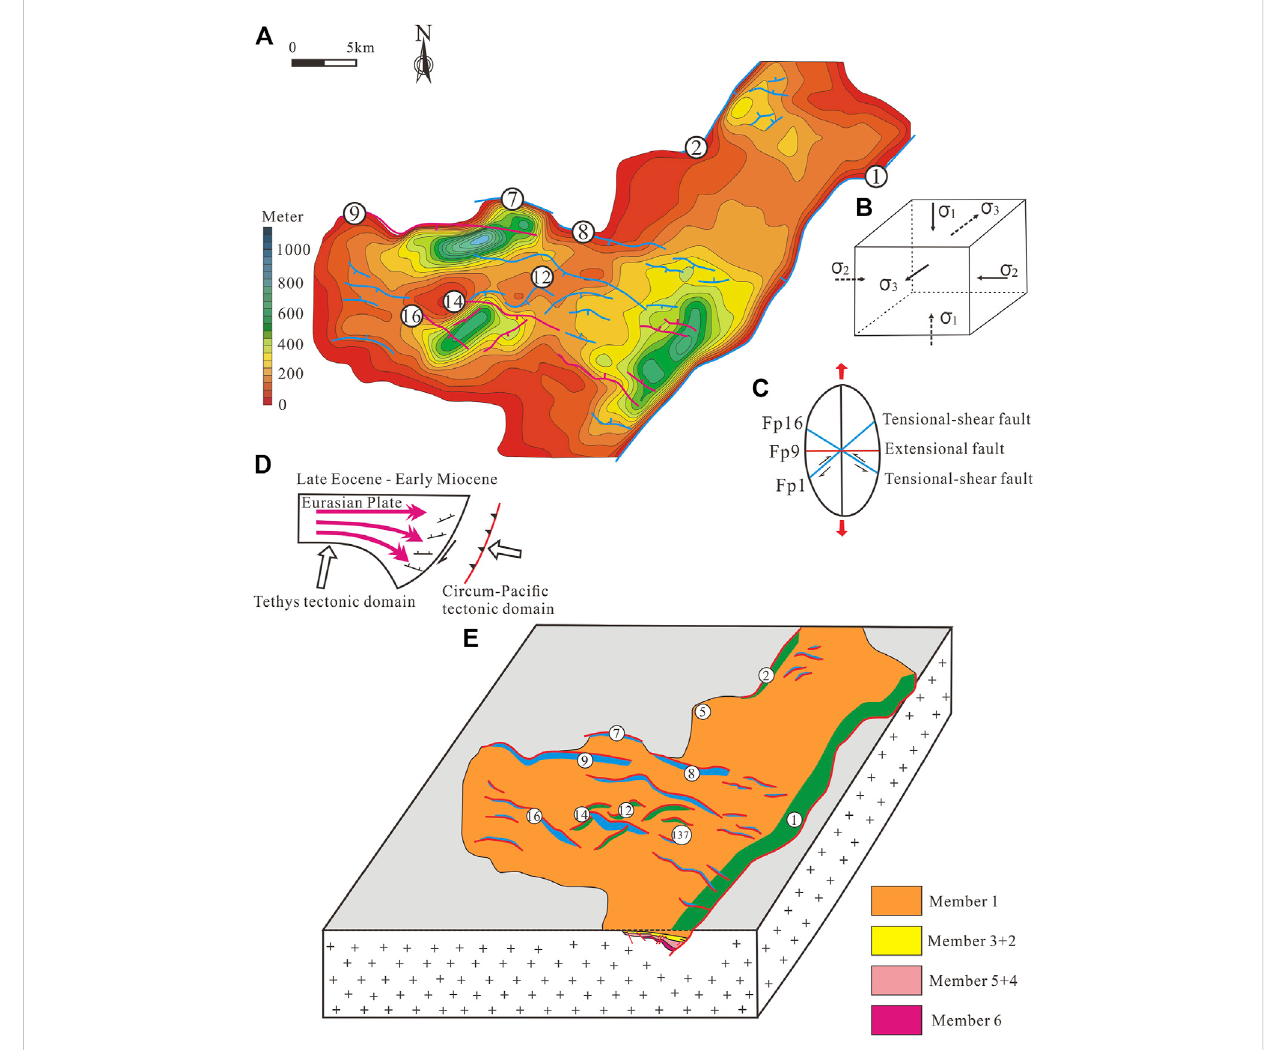
FIGURE 14 (A) The prototype basinofMember1inWenchang Formation; (B) Three-dimensionalstressstate ofprincipalstressinthelateEoceneofPaleogene; (C) Strain ellipse under the direction of N-S; (D) Movement status of Eurasian Plate, Tethys tectonic domain and Circum-Paci fi c tectonic domain; (E) Formation model